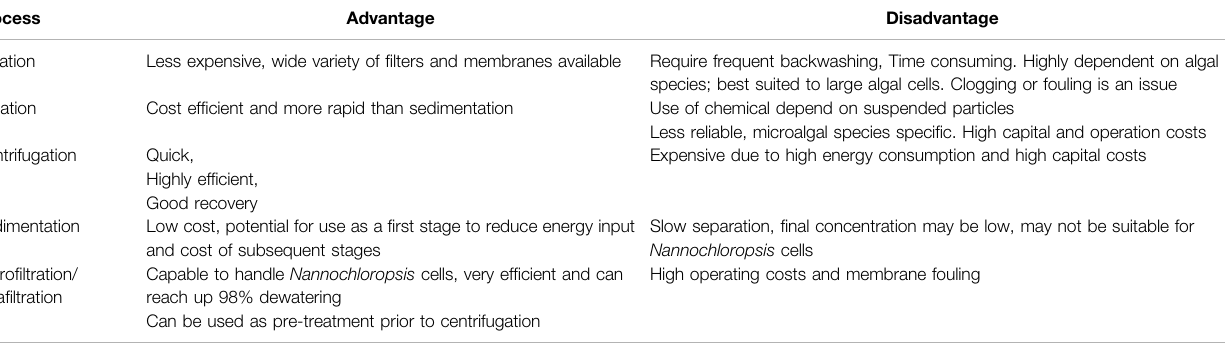
TABLE 2 | Strengths and limitations of harvesting techniques adapted from (Mohn, 1988; Grima et al., 2003; Shen et al., 2009).